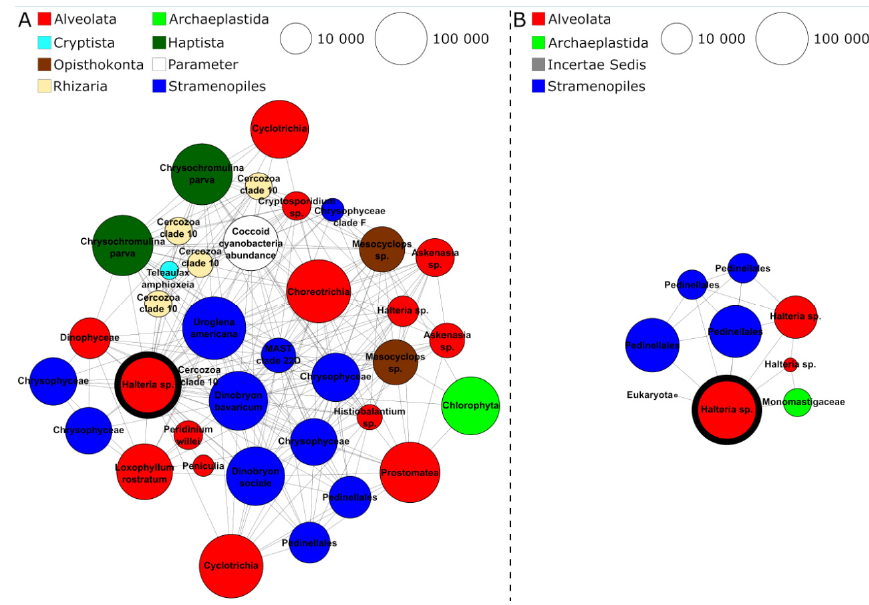
Figure 6. Species-specific co-occurrence subnetworks of Halteria sp. in both seasons. One network sequence cluster (NSC) assigned to the ciliate Halteria sp. was identified as a key node in the networks of both seasons. The Halteria sp. key node is highlighted by a bold black circle. All directly neighboring nodes of this Halteria sp. node are displayed in the subnetworks above. Panel A shows the subnetwork of the cold season, panel B the subnetwork of the warm season. Node colors reflect the taxonomic assignment of NSCs on higher taxonomic levels. Node sizes reflect the read abundance of NSCs in the metabarcoding dataset.